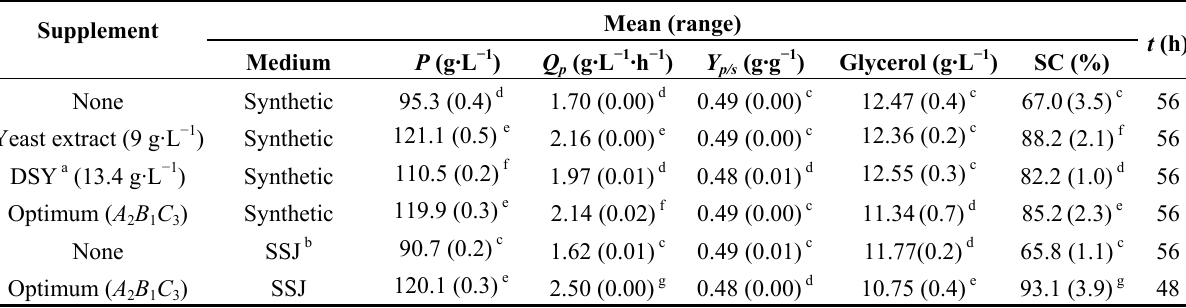
Table 5. Fermentation parameters of batch ethanol production under VHG fermentation at 280 g·L − 1 of total